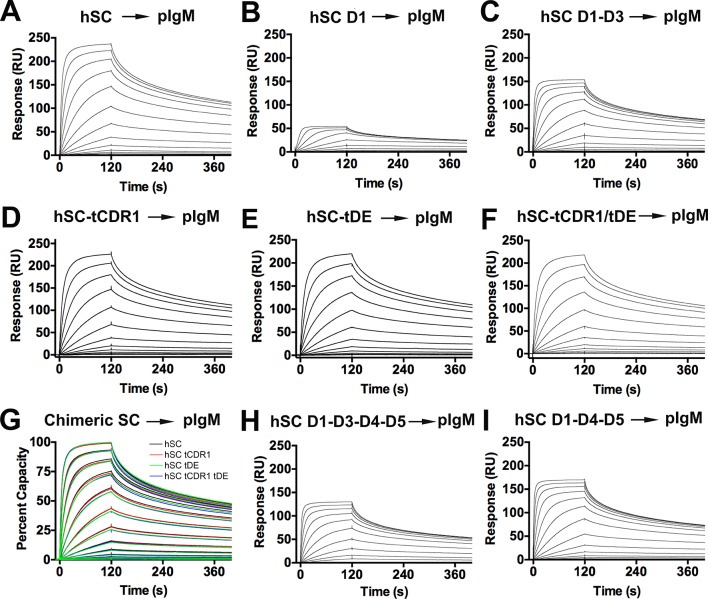
hSC and chimeric SC binding to pIgM.(A-F) Sensorgrams showing the responses of hSC D1-D5, D1, D1-D3 and chimeric SCs binding to pIgM. (G) Overlay of sensorgrams showing normalized response of D1-D5 and chimeric SC binding to pIgM. (H-I) Sensorgrams showing the response of D1-D3-D4-D5 and D1-D4-D5 binding to pIgM. All results were consistent among independent replicate experiments (not shown). Highest concentrations for hSC D1-D5, D1-D3, D1-D3-D4-D5 D1-D4-D5, tCDR1, tDE, tCDR1/tDE were 256nM. Highest concentration for D1 was 16nM.